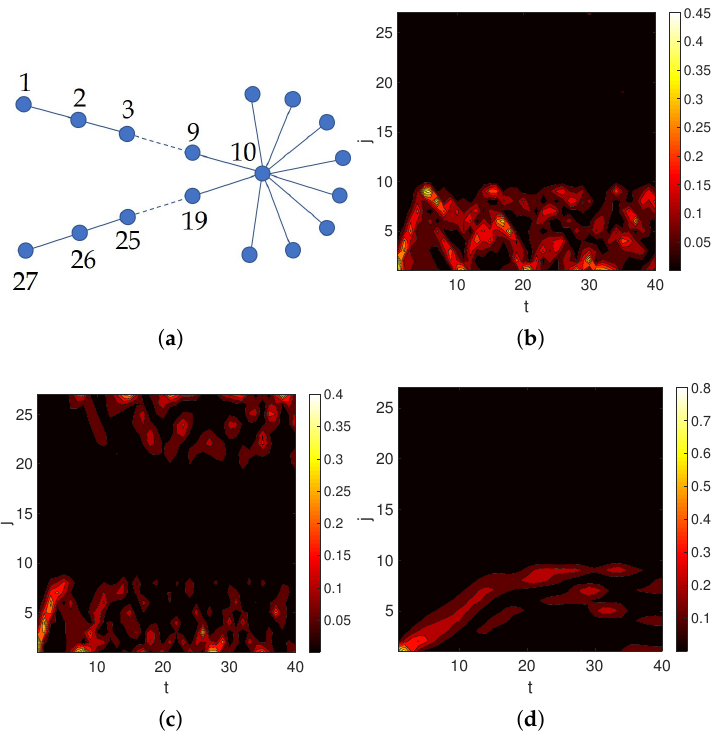
Figure 7. Plot of the transition probability π 1, j for a quantum particle located at t = 0 at position v = 1 of the tree illustrated in ( a ) without LRI ( b ), with L s = 2 ( c ) and with L γ = 0.25 ( d ). The colobar corresponds to the transition